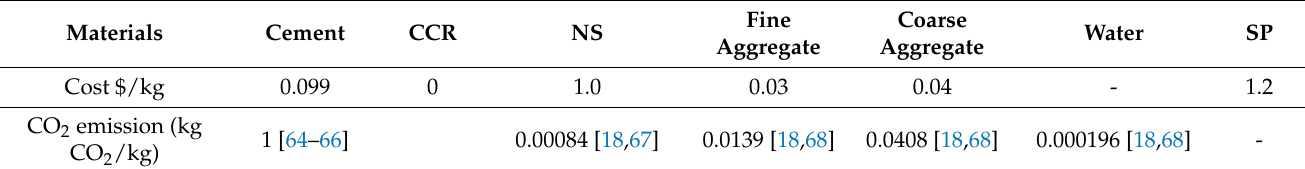
Table 4. Cost and CO 2 Emissions of Constituent Materials.